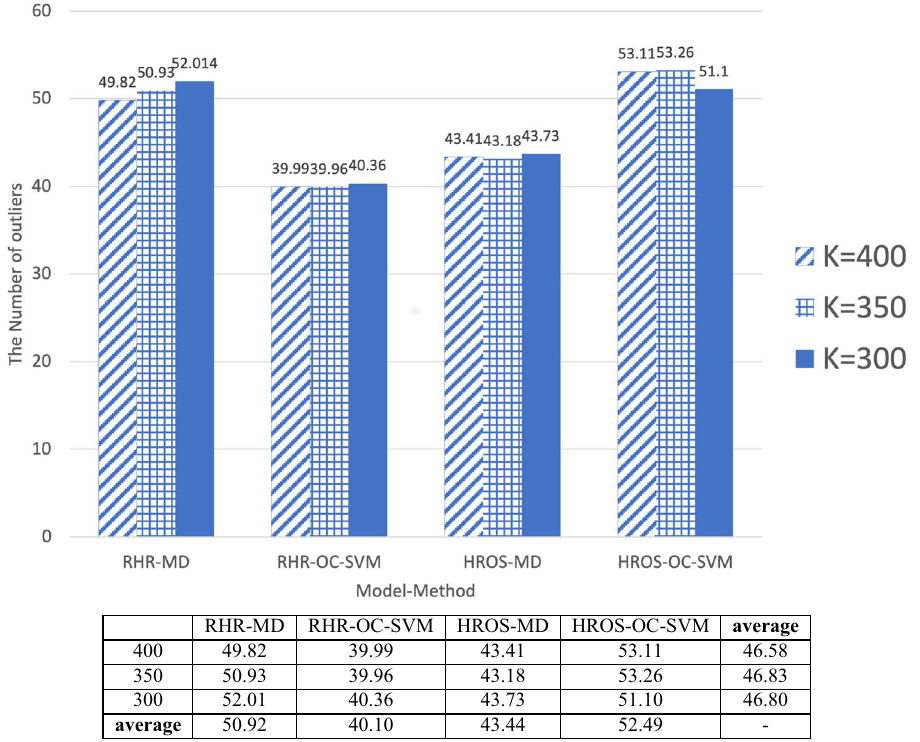
Figure 5. The total number of outliers from COVID-19 negative participants.